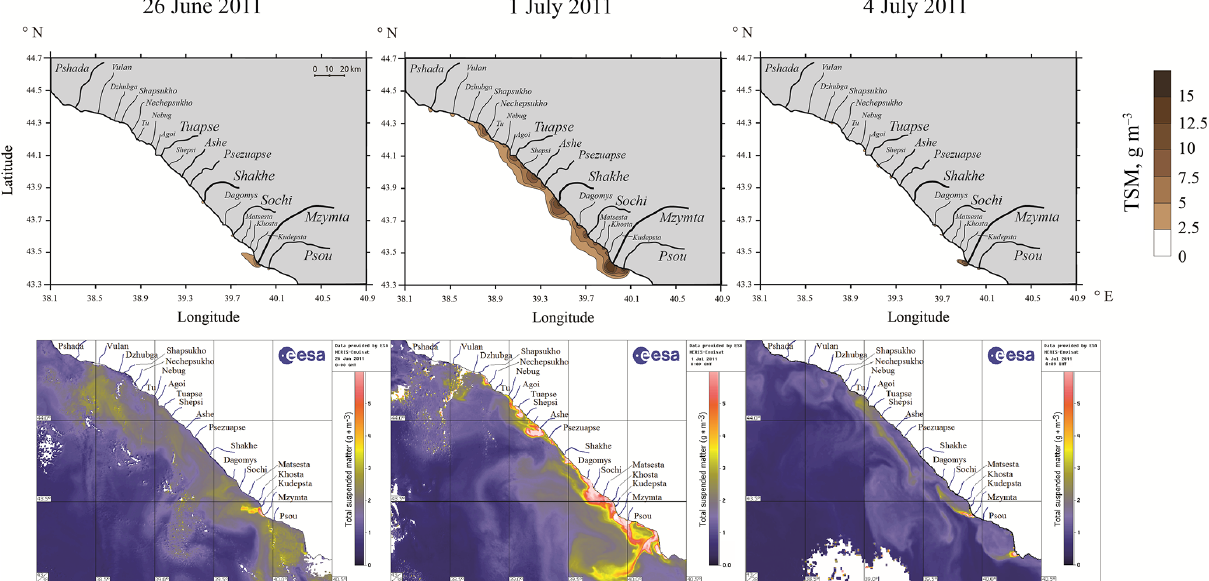
Figure 10. Modeled real mode (top panel) and satellite-derived (bottom panel) surface TSM distributions at RCBS on 26 June, 1 July, and 4 July